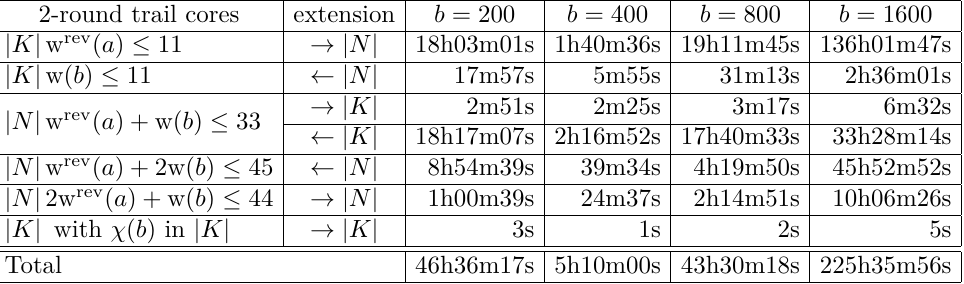
Table 6: Execution time for the extension of 2-round trail cores to 3 rounds. Symbols → | K | and → | N | denote forward extension in the kernel and outside the kernel respectively; ← | K | and ← | N | denote backward extension in the kernel and outside the kernel respectively.